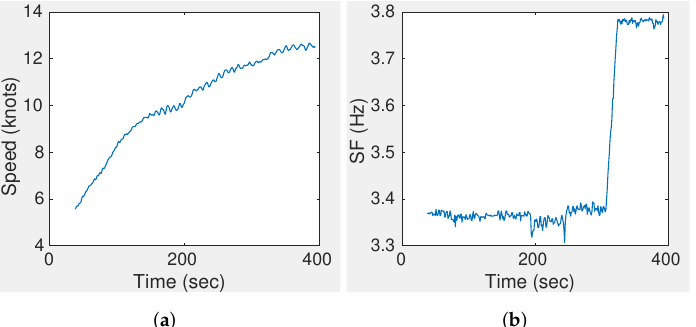
Figure 12. ( a ) Ship speed and ( b ) fundamental propeller shaft frequency SF 1 change with time when the ship changed both propeller revolutions per minute (RPM) and propeller pitch ratios.